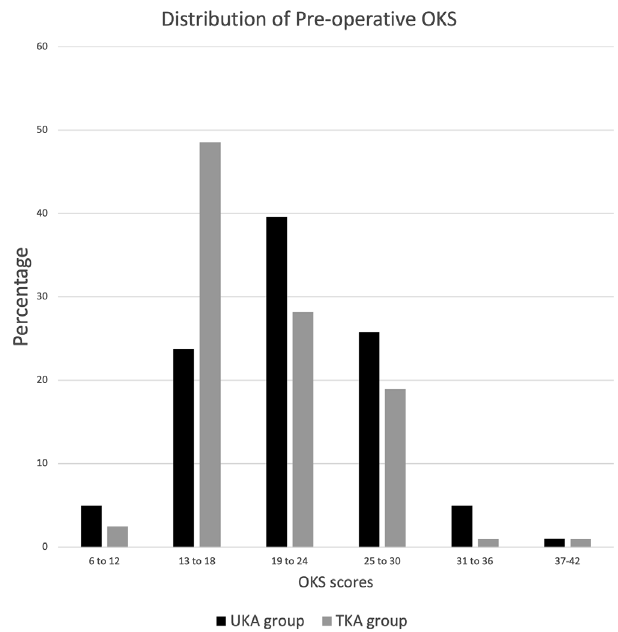
Figure 4. Histogram depicting the distribution of the pre-operative Oxford Knee Score of both the cohorts.